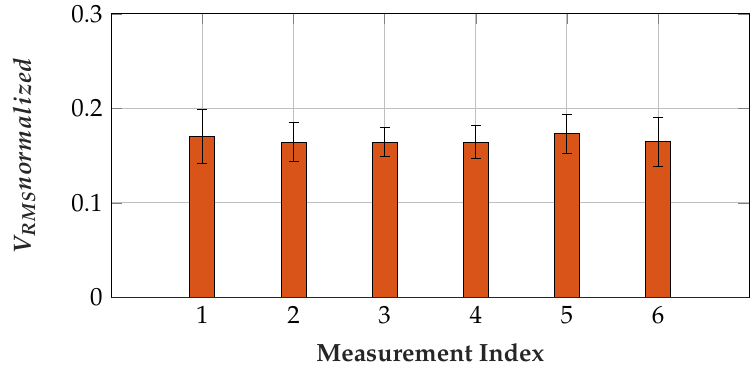
Figure 18. Normalized V RMS values did not decrease over the 18 maximum voluntary contractions measured with Sensor 5. One bar comprises the mean of three subsequent measurements of five